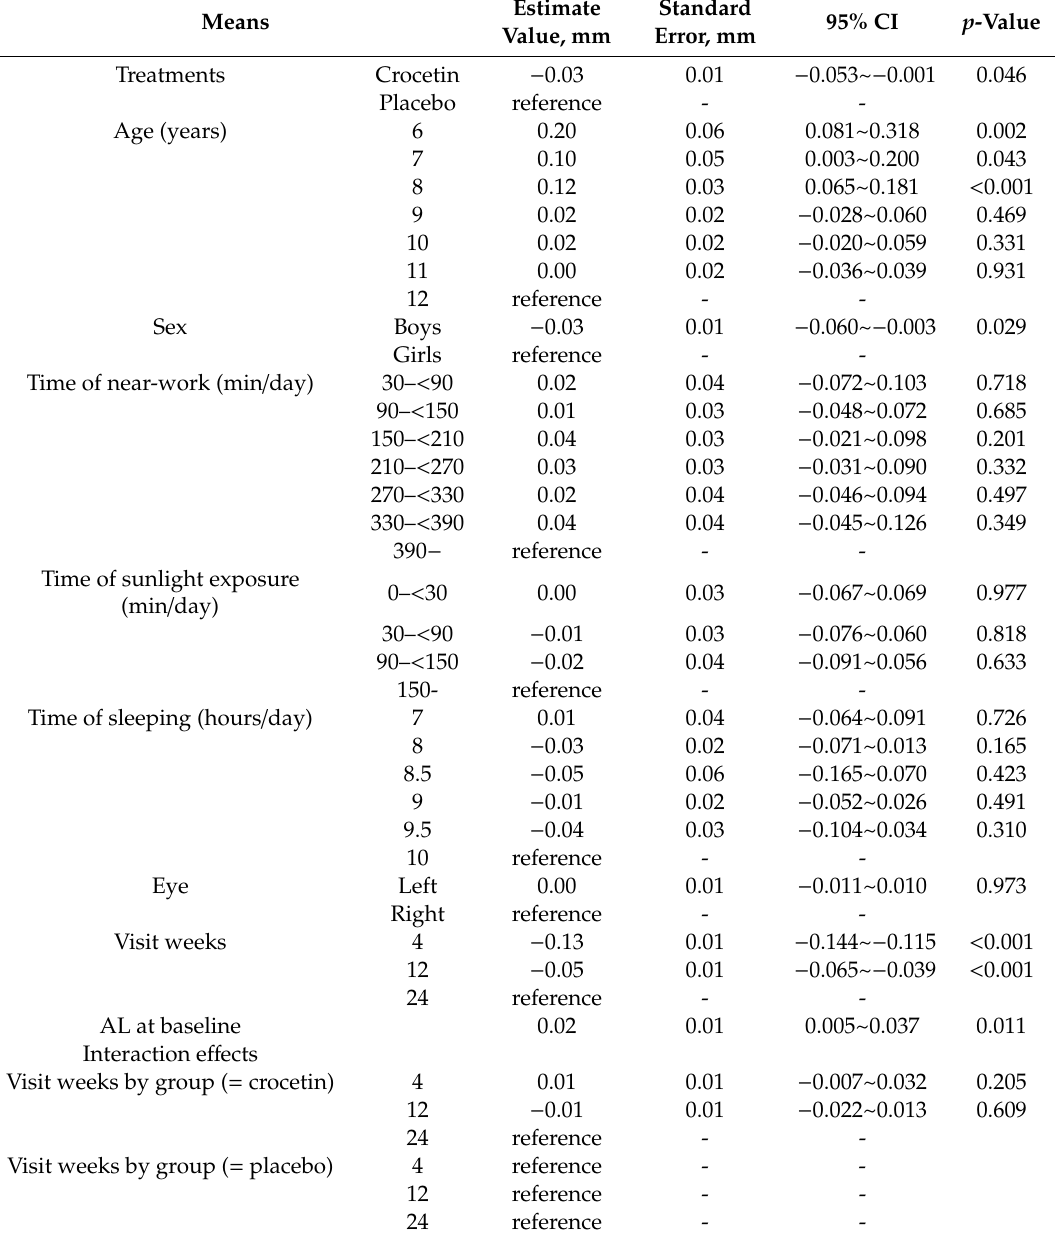
Table 4. Results of the mixed-e ff ects model fitted to 24-week AL change for both eyes. Estimate Standard Means Value, mm Error, mm Treatments Crocetin Placebo reference